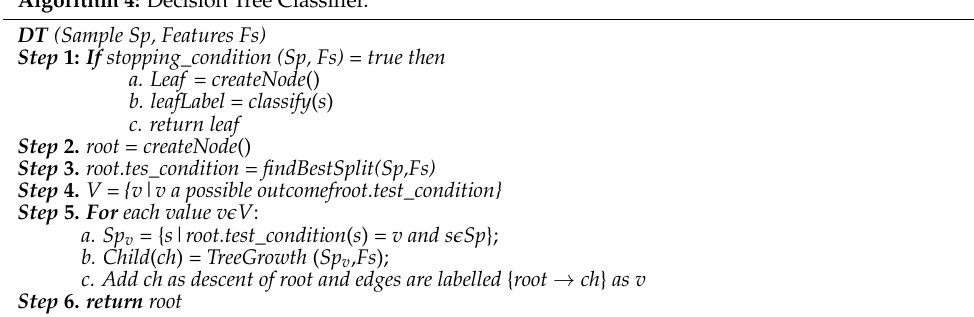
Algorithm 4: Decision Tree